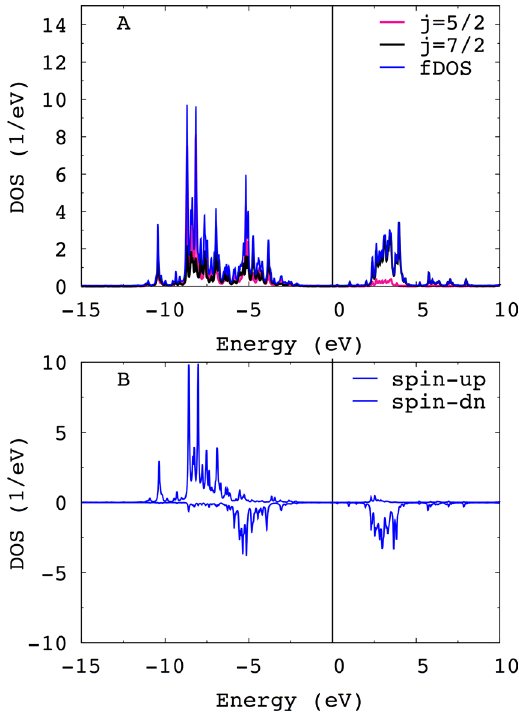
Figure 1. The total and j = 5/2, 7/2 projected fDOS for the fcc-Ho@Pt(111) ( A ); the spin projected fDOS for the fcc-Ho@Pt(111) ( B